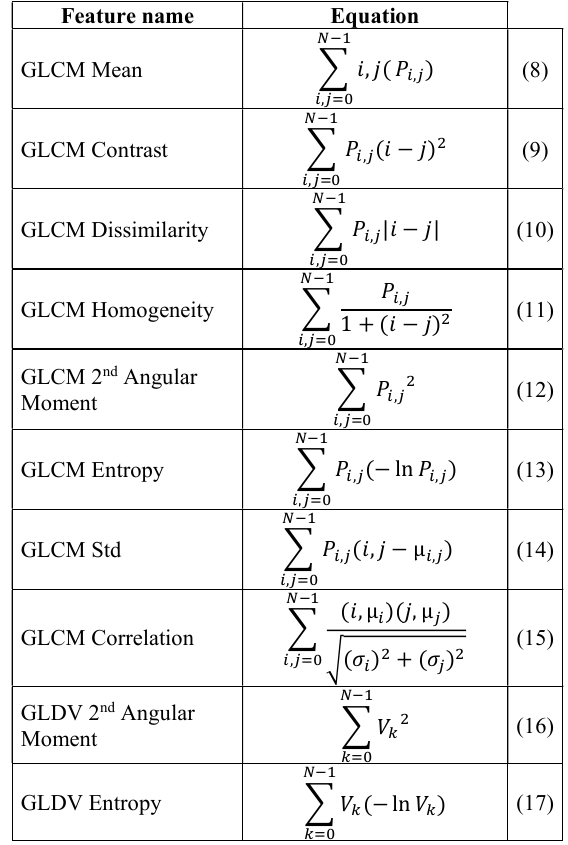
Table 3: Texture features extracted for both Sentinel-2 images, where, P i,j = normalized value for the cell i,j; N = number of rows or columns; µ i,j = GLCM mean; σ i,j = the GLCM Std; Vk = the image object level.